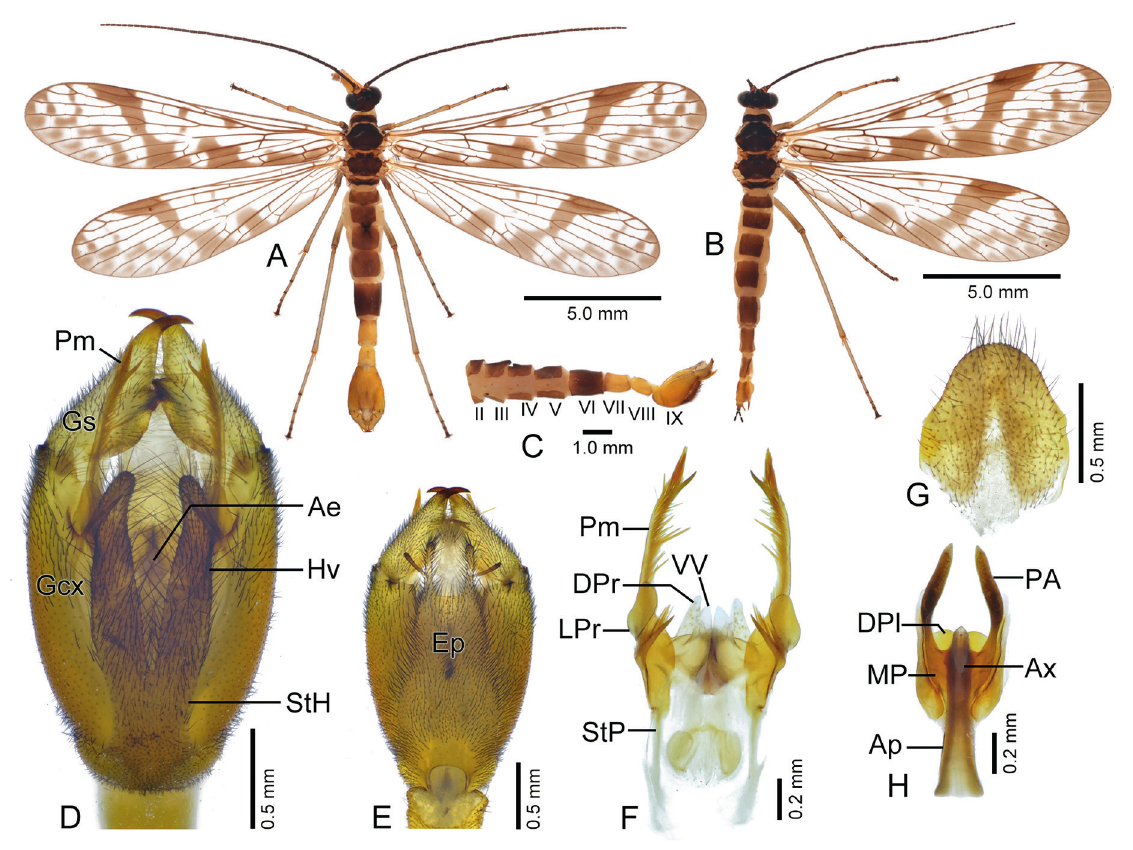
Fig. 2. Panorpa implicata Cheng, 1957. A , C – F . ♂ (DALU). B , G–H . ♀ (DALU). A – B . Habitus, dorsal view. C . Abdomen, left-lateral view. D – E . Genital bulb, ventral and dorsal views, respectively. F . Aedeagal complex, ventral view. G . Subgenital plate, ventral view. H . Medigynium, ventral